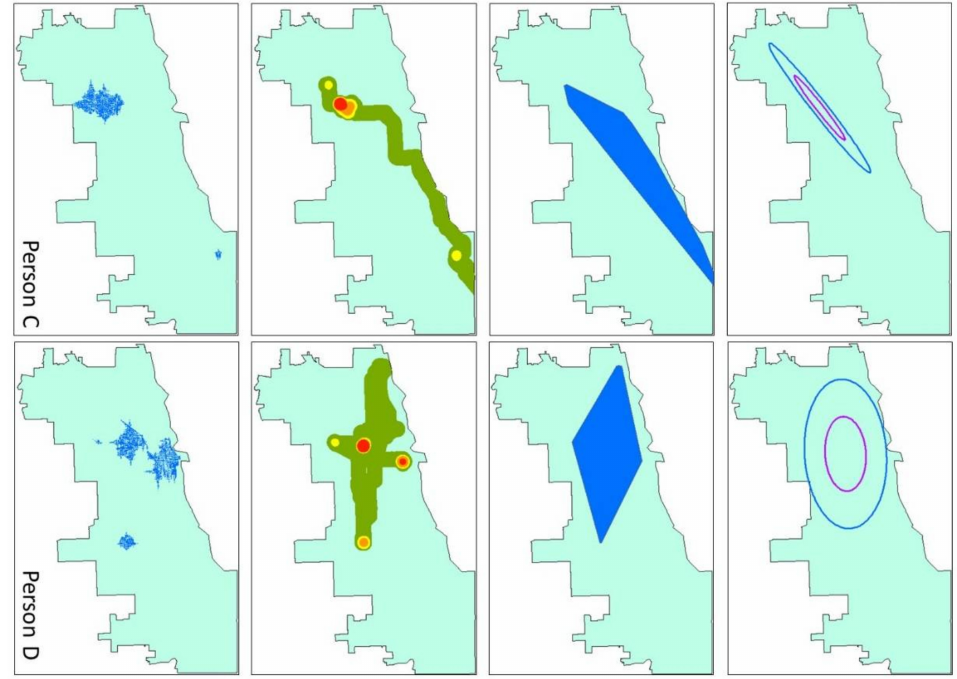
Figure 9. The four representative persons’ activity spaces generated by different methods.